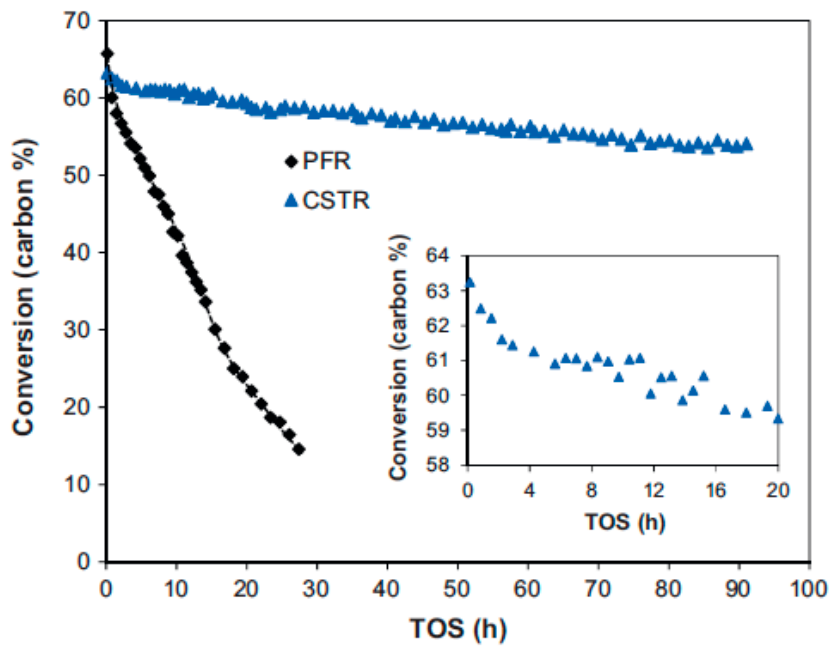
Figure 5. MTO reaction over the H-ZSM-5-S catalyst in the PFR at ambient pressure and the H-ZSM-5-S catalyst in the CSTR at 6.5 bar, T = 723 K and p MeOH = 178 mbar. Adapted with permission from ref. [83]. Copyright 2015 Elsevier.